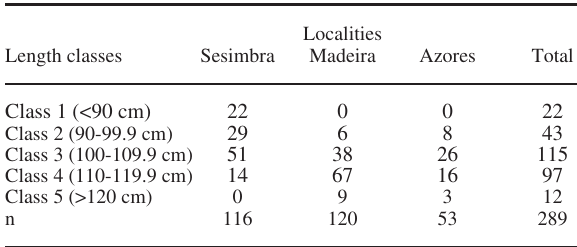
Table 1. – Black scabbardfish ( Aphanopus carbo ) distribution for each fork length class. localities length